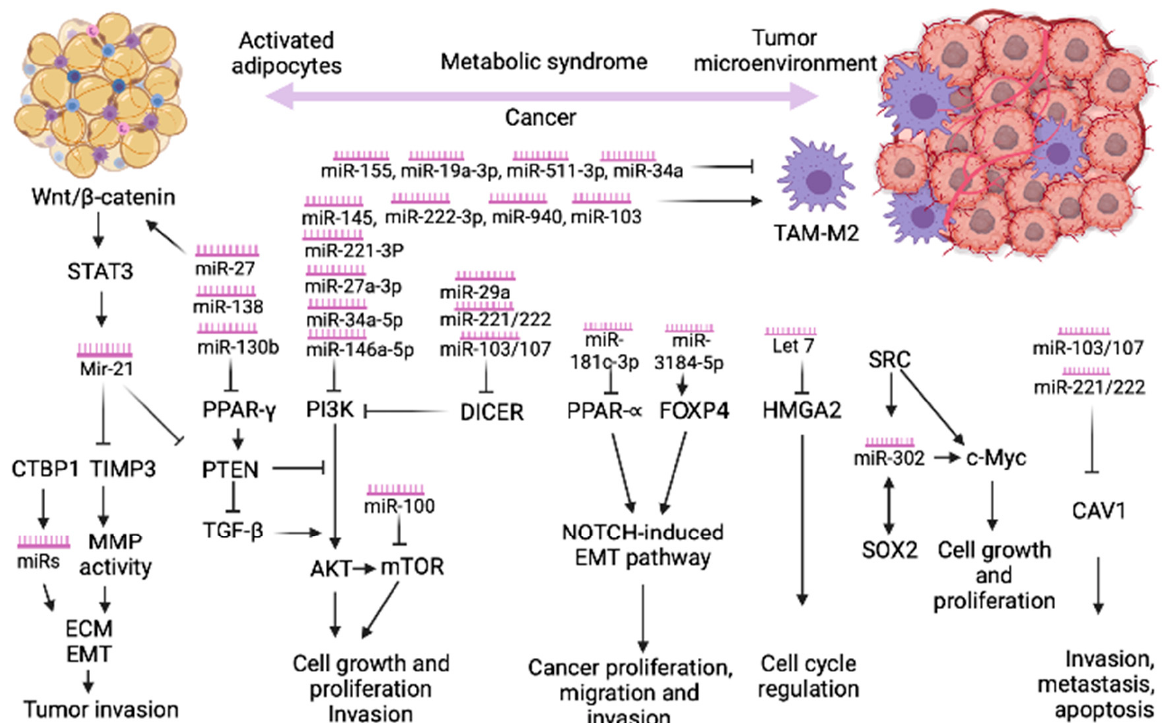
Figure 1. Signaling pathways and the corresponding miRs implicated in MetS- associated cancer. Several miRs are deregulated in both MetS/obesity and various types of cancers. Mir-21 is regulated by B-catenin via STAT3 and plays a role in oncogenesis and cancer progression through its direct targets TIMP3, which modulates matrix MMP activity and the PTEN/PI3K/AKT signaling pathway. PI3K/AKT represents the prevalent pathway implicated in carcinogenesis and MetS/obesity. The Mir221/222 cluster is implicated in both IR and cancer via CAV1, a key regulator for cell proliferation, apoptosis, migration, and metastasis. Other pathways implicated in cancer initiation and progression are: NOTCH-induced EMT, HMGA2, SOX2, c-Myc. TAM—tumor associated macrophages, MMP—matrix metalloproteinases, EMT— epithelial–mesenchymal transition, ECM–extracellular matrix, STAT3—signal transducer and activator of transcription 3, TIMP3—tissue inhibitor of metalloproteinase 3, PPAR- γ —peroxisome proliferator-activated receptor gamma, PTEN– phosphatase and tensin homolog, PI3K—phosphoinositide 3-kinase, AKT—protein kinase B, mTor—mammalian target of rapamycin, PPAR- α —Peroxisome proliferator activated receptor alpha, HMGA2—high mobility group AT-hook 2, SRC— Proto-oncogene tyrosine-protein kinase Src, SOX2—SRY-Box transcription factor 2, c-Myc—Cellular myelocytomatosis oncogene, CAV1—Caveolin 1.